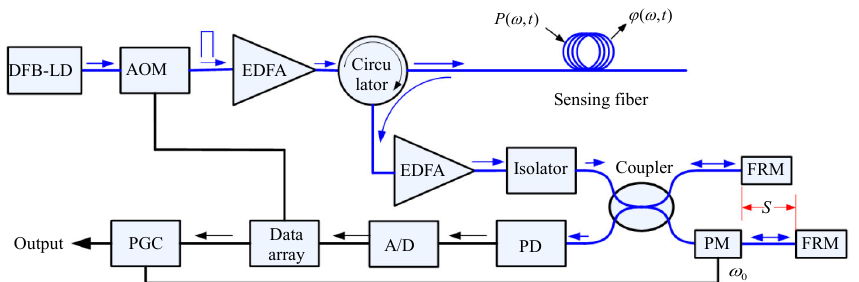
Fig. 1 DAS system block